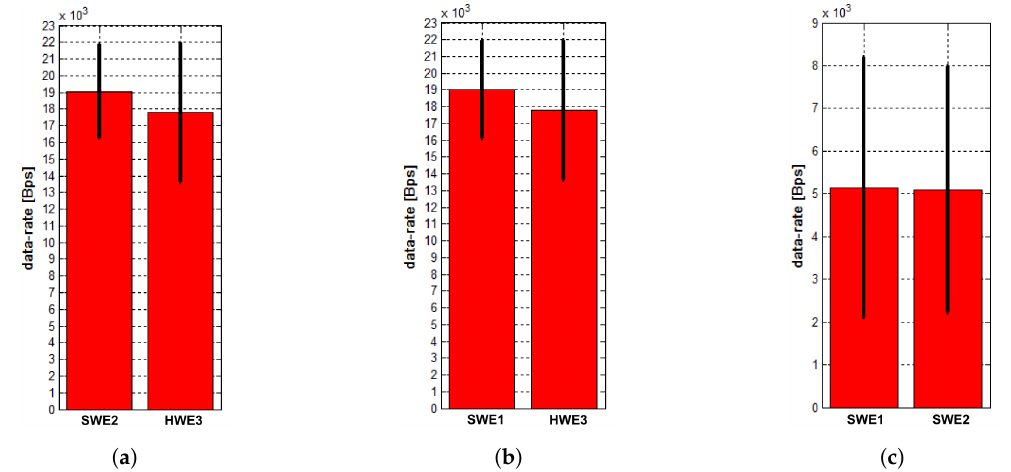
Figure 11. Mean values and standard deviation of data rates of transmissions from neighbors measured at entities ( a ) SWE 1 ; ( b ) SWE 2 ; and ( c ) HWE 3 in the MR scenario without the use of the high-fidelity MR architecture when data is sent at a rate of 20 kBps.